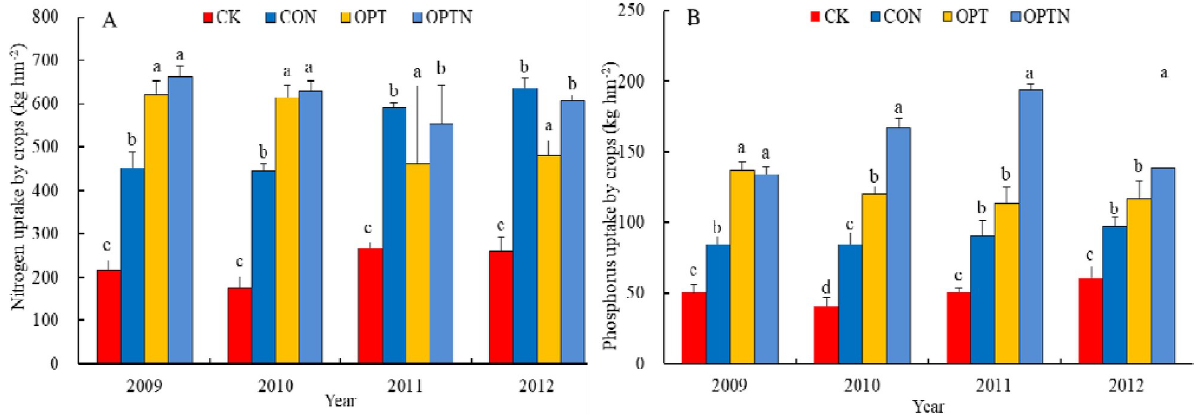
Fig 3. Nitrogen and phosphorus uptake of cotton under four treatments (kg hm -2 ). Note: Data were mean ± standard error (n = 3). Different letters within a column indicate significant differences among treatments by ANOVA followed by Duncan’s test ( p � 0.05). The corresponding results are presented in Table